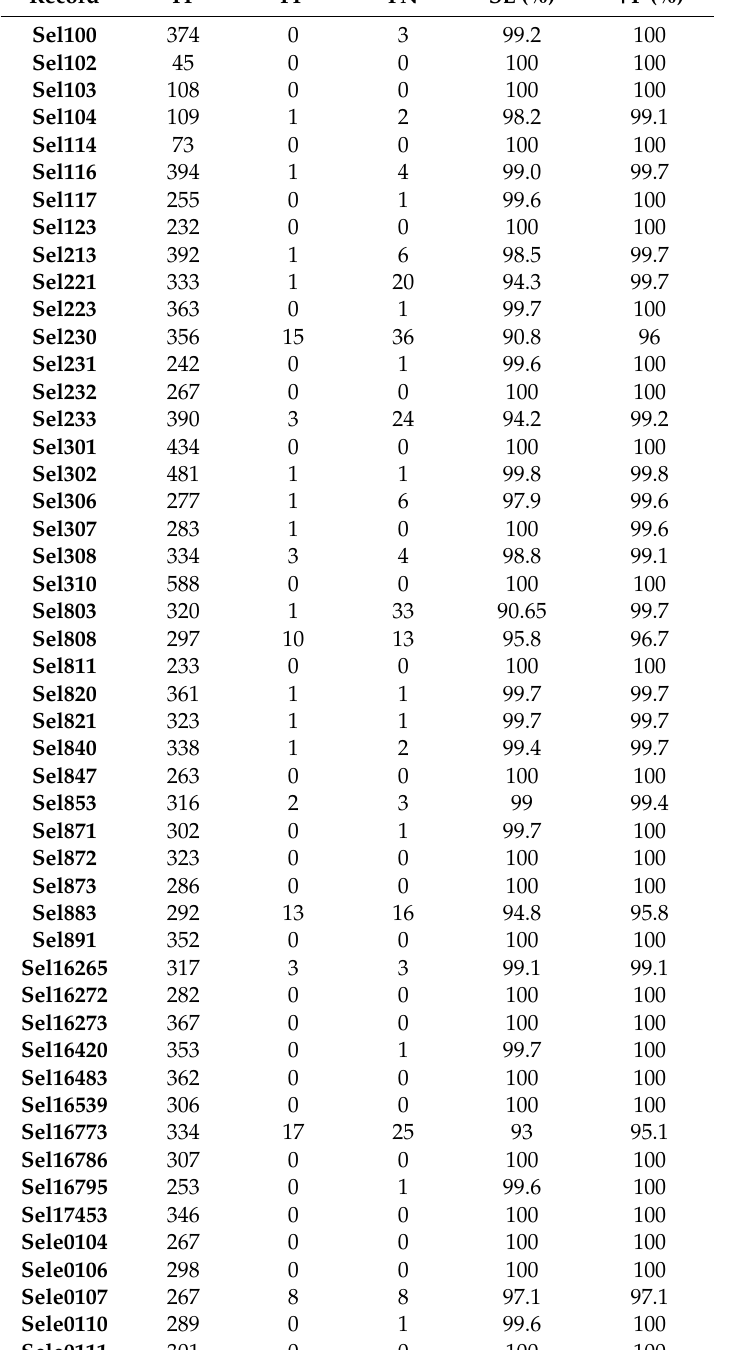
Table 3. P-wave detection performance over the automatically annotated QT